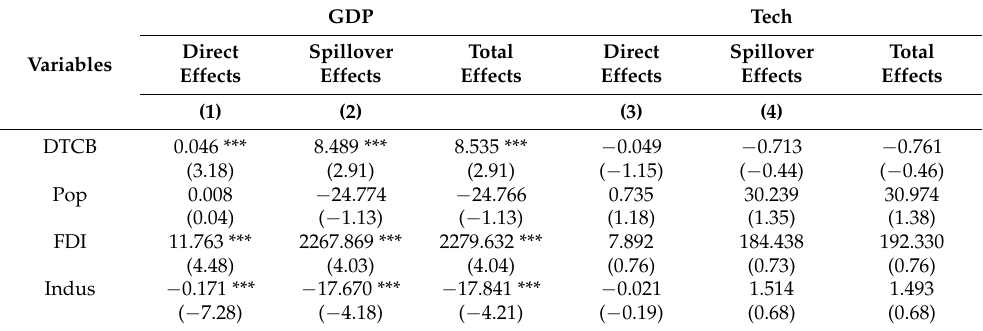
Table 12. Mechanism